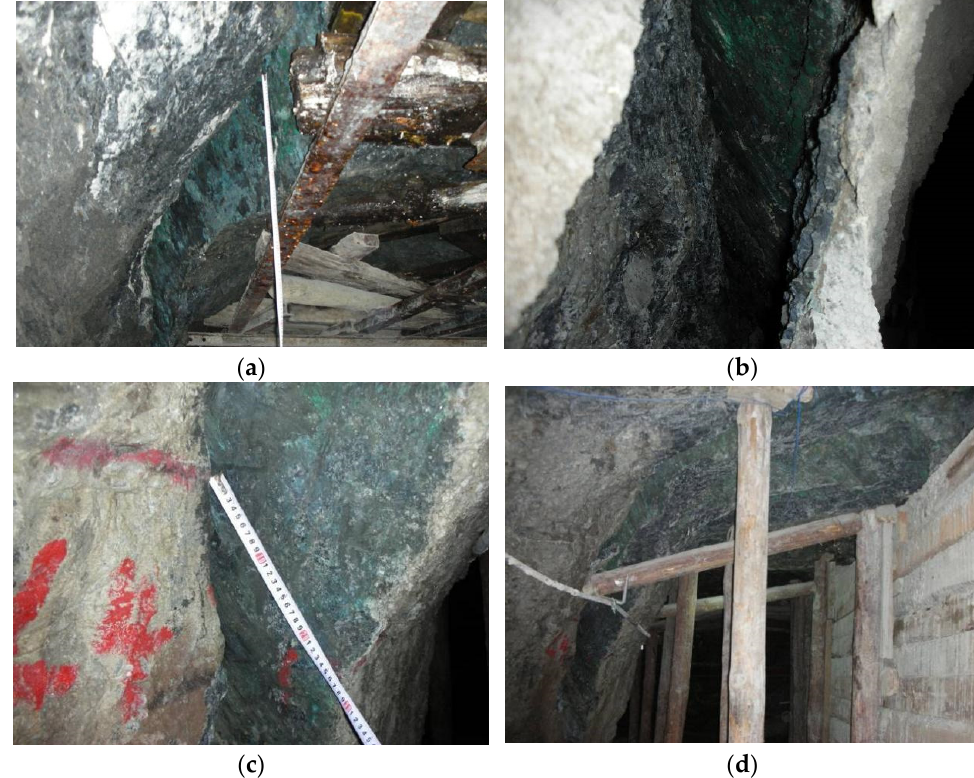
Figure 3. Partial slip photos of fault F2 (April 2010); they should be listed as: ( a ) The dislocation along the fault in the sublevel 12 roadway; ( b ) Fault movement along the fault in the bypass of sublevel 12’s chute; ( c ) Sliding of the fault near the chute in the sublevel 12; ( d ) Fault dislocation of material chamber in sublevel 12.